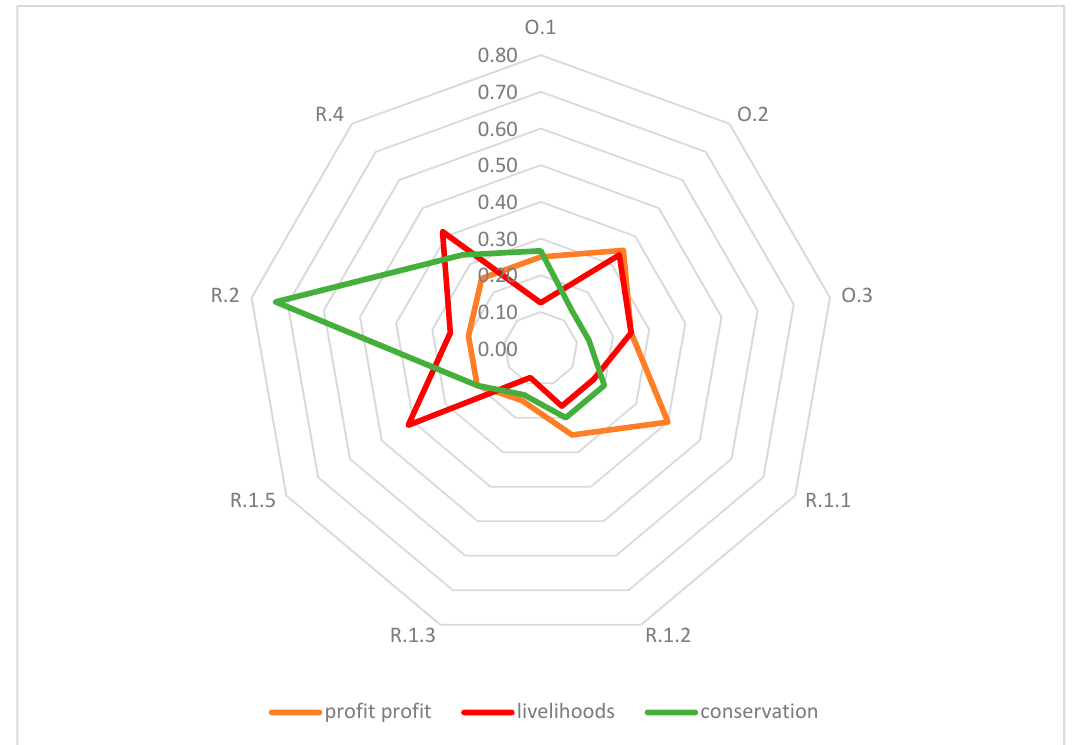
Figure 3. Land tenure attitudes and core beliefs.